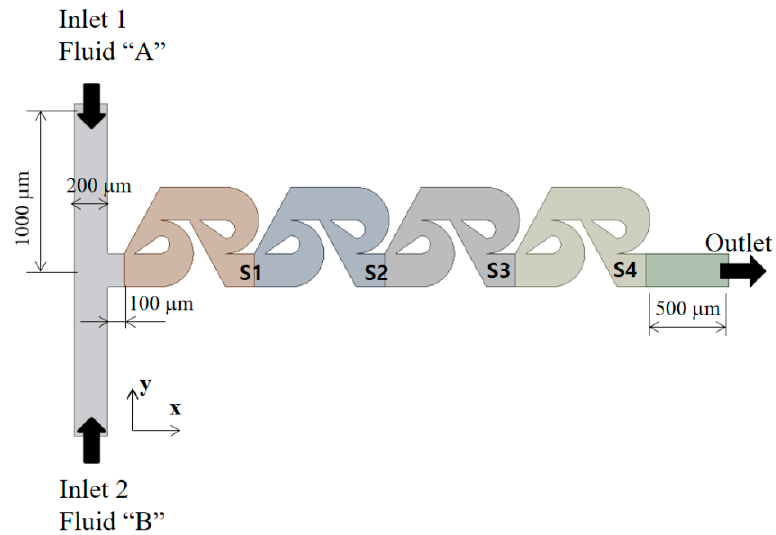
Figure 2. Schematic diagram of present micromixer (non-proportional).